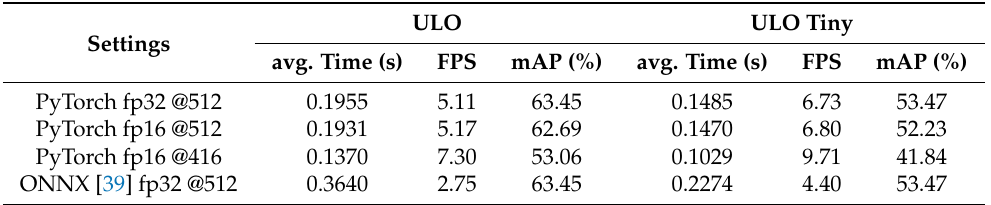
Table 4. The average processing time, FPS, and mean precision of each model evaluated on Nvidia Jetson